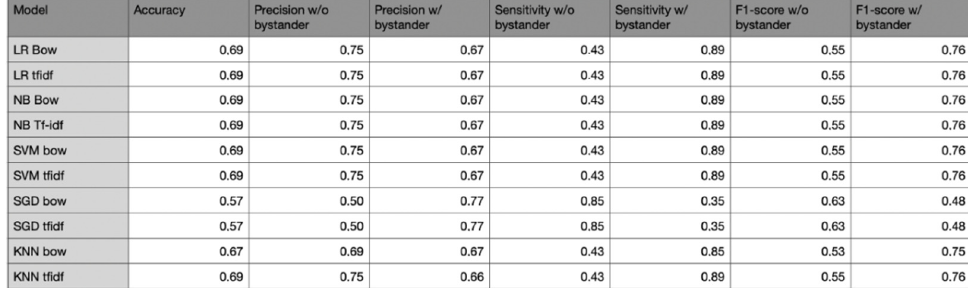
Figure 20. Simple model metrics applied to full descriptions. In this case, the models greatly improved their F1-score with respect to the models with complete descriptions, due to a great increase in sensitivity. However, the accuracy and precision dropped to a great extent, having an accuracy for the category “with witness” of approximately 40%. This would imply that only 40% of the elements in the token category would be well classified. A good text processing and feature extraction applied to the complete descriptions before inference would allow us to reach the accuracy of 67% described in 4.2. 5. Conclusions Several conclusions can be drawn from the exploratory data analysis presented in this paper. We launched this first analysis through all the information contained in our database, containing different cities and countries from all over the world. The first conclusion is that the predominant language of the reports is English, and therefore the text analysis must be carried out in English to obtain the most out of the database. The second conclusion is that there is a low rate of reports made by witnesses, which shows that there is a need to make people more aware of the importance of intervening and